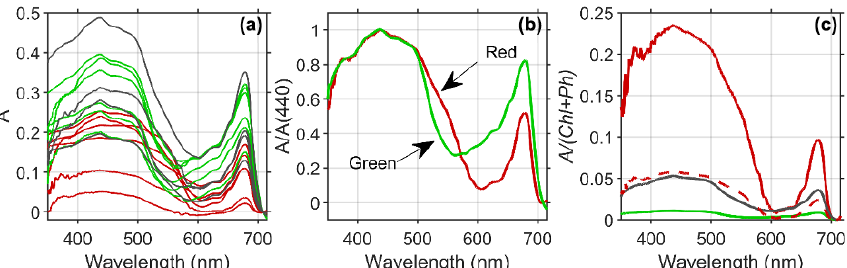
Figure 5. (a) Estimated absorptance ( A ) of the snow algae reveals distinct patterns of broad absorption in the blue or soret band (400– 500nm) and a secondary peak in red wavelengths (678nm) common to all algal groups, with green (green lines) and mixed (black lines) algae presenting higher absorption magnitude than red algae (red lines) due to enhanced pigment concentrations. (b) The spectral shape of mean absorption normalized at 440nm reveals that absorption by red algae (red line) is higher in the green wavelength compared to green algae (green line), which provide a means to discriminate between red and green algae using the reflectance spectrum. (c) Absorption normalized to chlorophyll plus phaeopigment biomass demonstrates that red algae (red line) communities absorb considerably more per milligram of pigment compared to mixed (black line) or green (green line) algae patches. The dotted red line includes estimated pigment contribution from astaxanthin esters in red algae (3 : 1 relative to chlorophyll a ; Davey et al.,